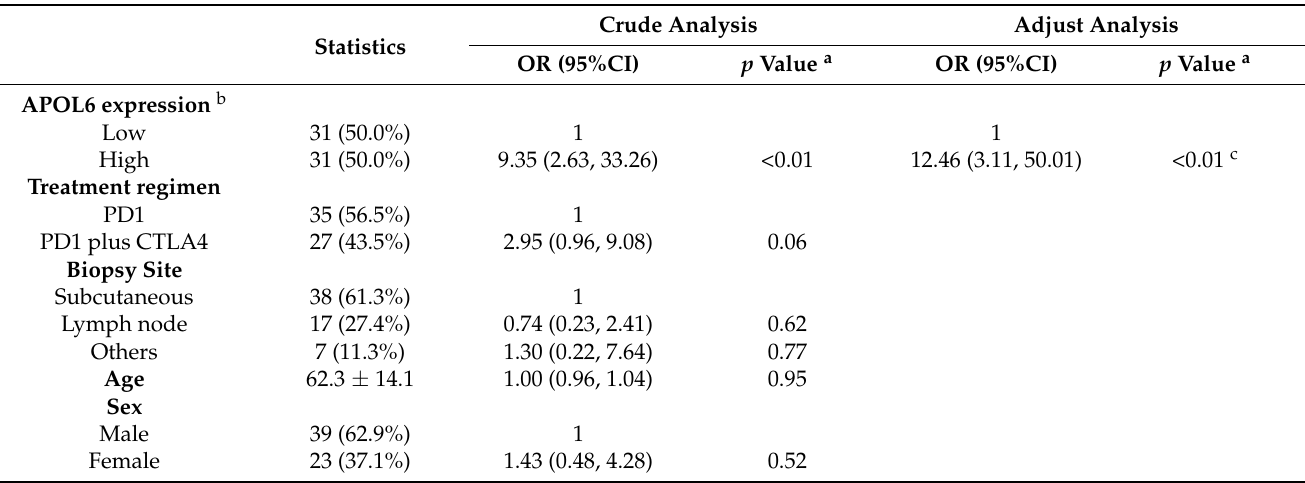
Table 1. Univariate and multivariate analyses of factors associated with response to immunotherapy in the melanoma cohort.